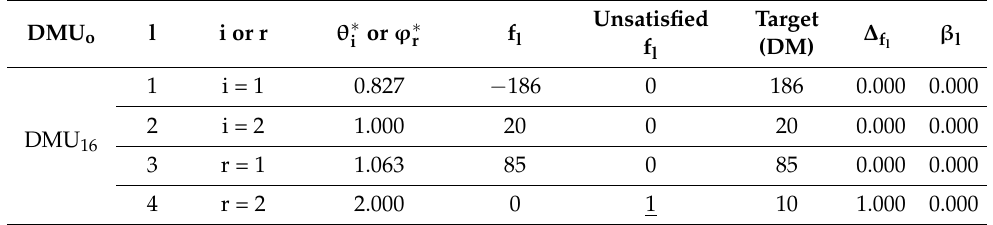
Table 7. Calculated parameters through solving of step 2 of STEM (p = 1) models for DMU 16 (the first case study).